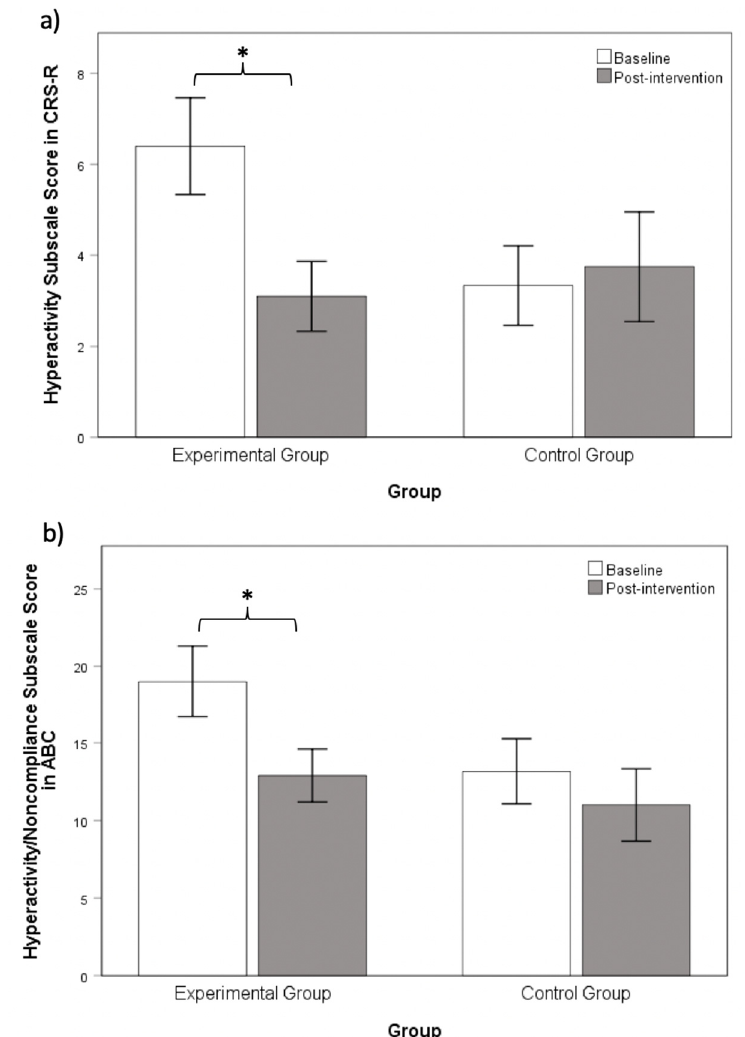
Figure 5. Mean parental rating on children’s hyperactive behaviors in the experimental and control groups before and after intervention. The experimental group shows a significant reduction in hyperactivity in ( a ) CRS-R and ( b ) ABC after intervention, whereas the control group does not show such a reduction. CRS-R = the short form of Conners’ Rating Scales—Revised; ABC = Aberrant Behavior Checklist. * p < 0.01 in paired samples t -test. Error bars represent 1 standard error ± mean.